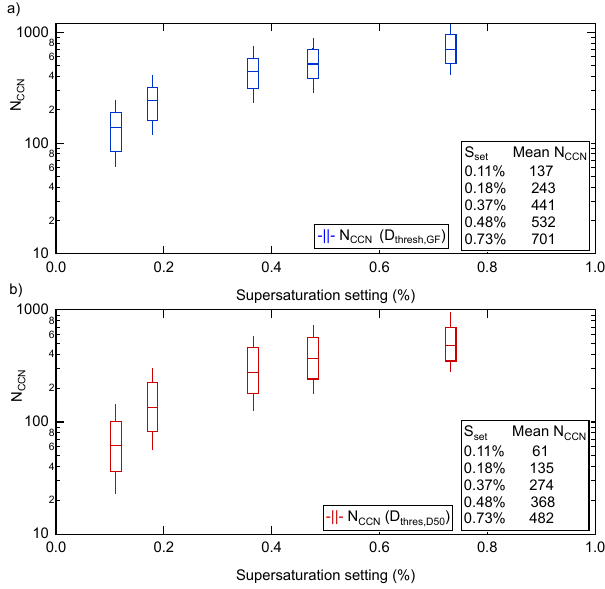
Fig. 11. N CCN vs. S set for (a) as derived from HTDMA data and (b) derived from CCNc D-step analysis. The tables show the mean N CCN concentrations at each